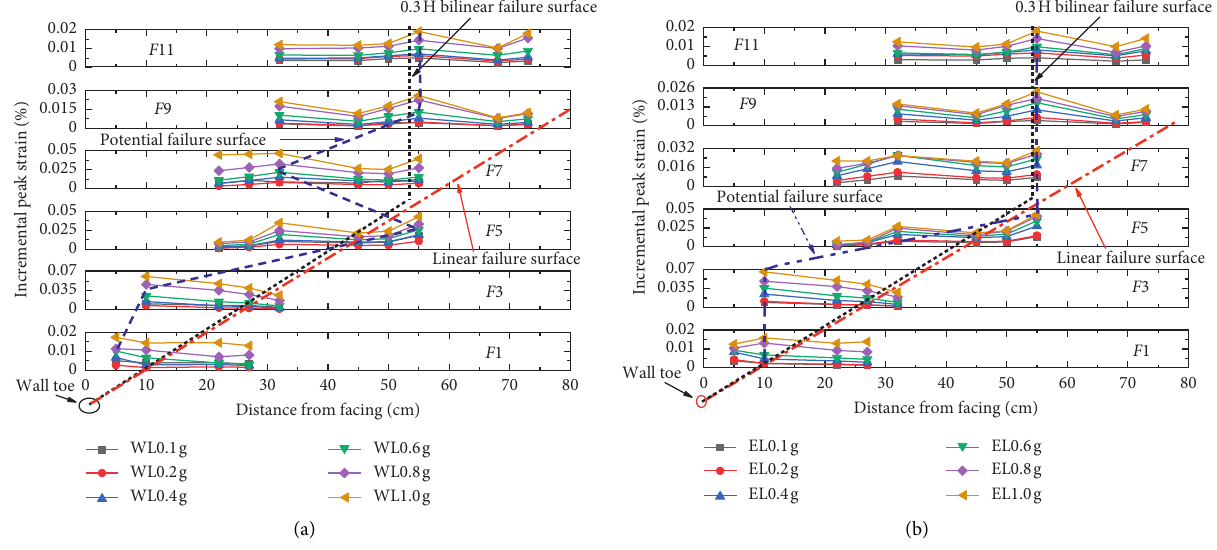
Figure 17: Distributions of the measured peak strain (scale factor: 1/2): (a) WL and (b)